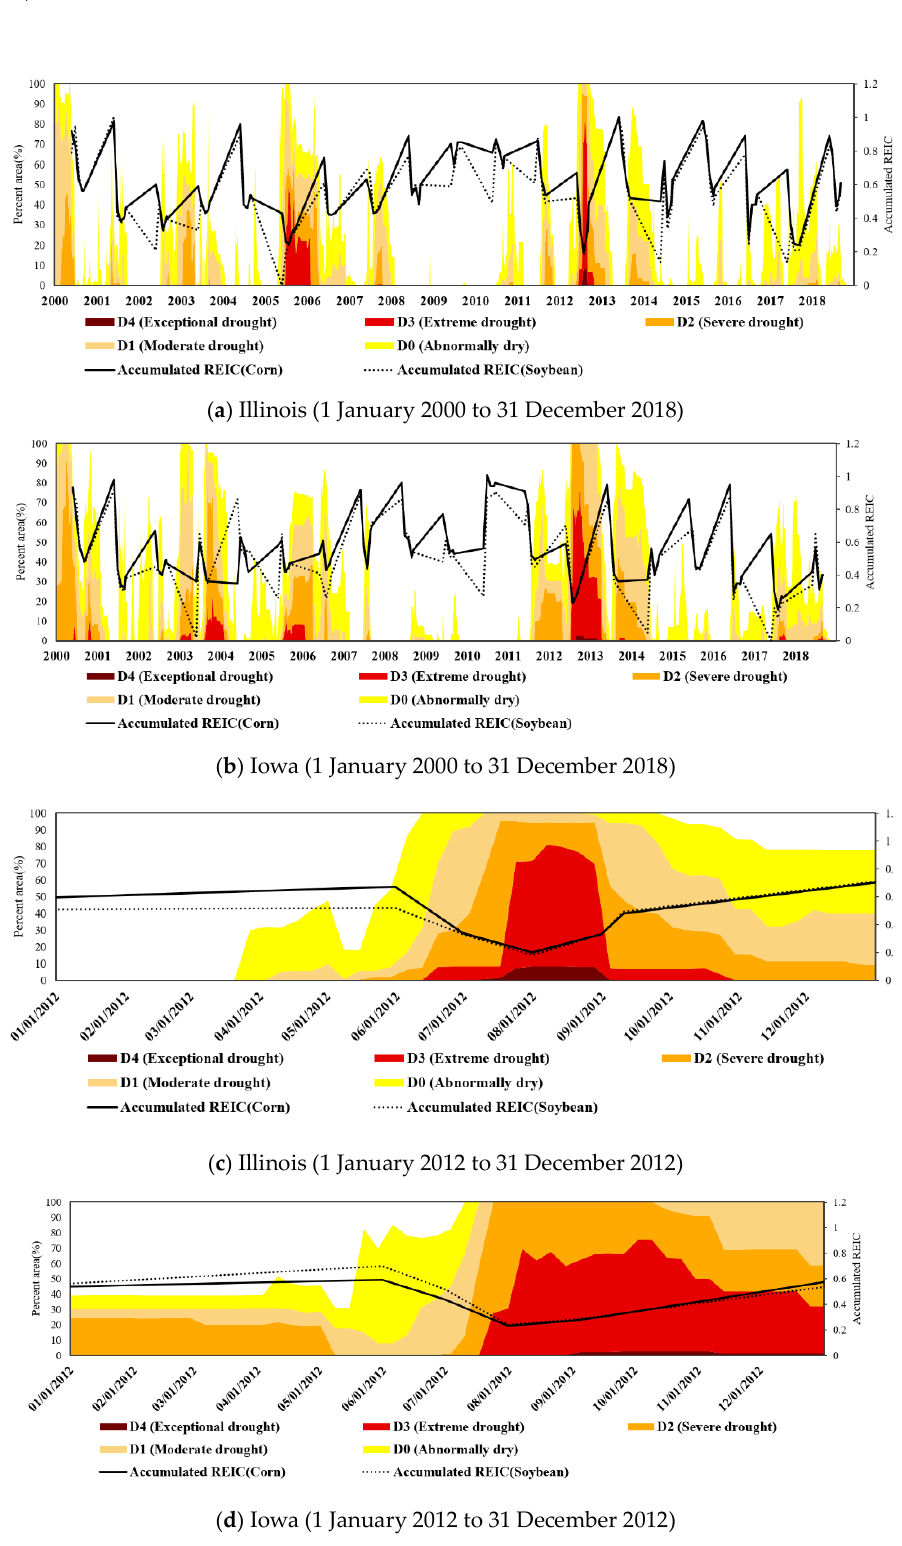
Figure 8. Record of U.S. Drought Monitor (USDM) drought for a specified period.